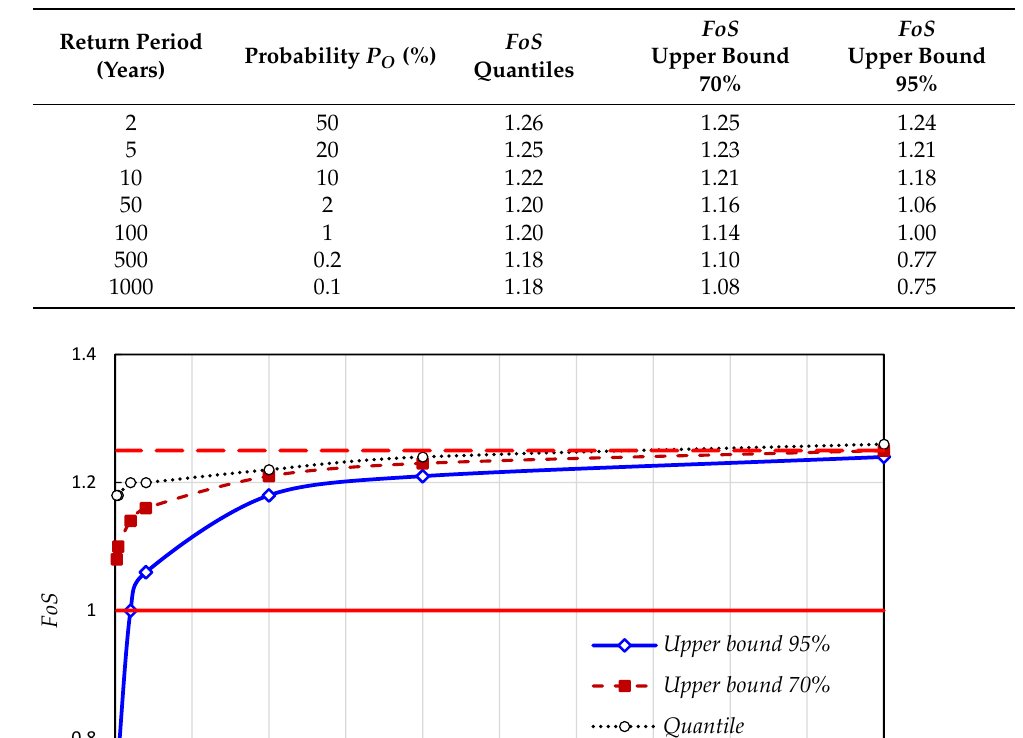
Table 5. FoS of the quantiles and upper bounds of the 70% and 95% CIs.